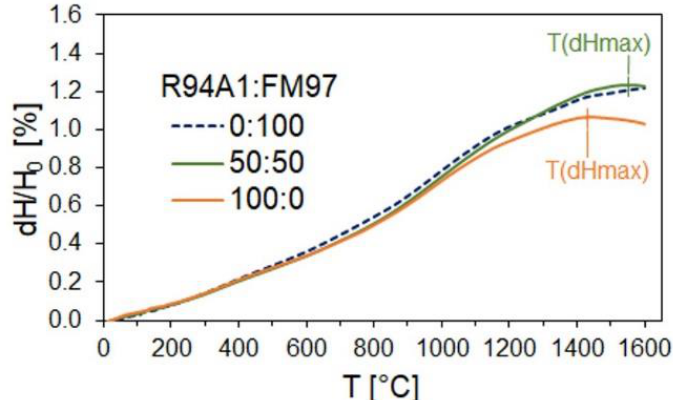
Figure 9. Refractoriness under load (RUL) of recyclate-containing MgO-C samples of composition R94A1:FM97 = 50:50 and 100:0 in comparison with the reference from only primary raw materials (R94A1:FM97 =